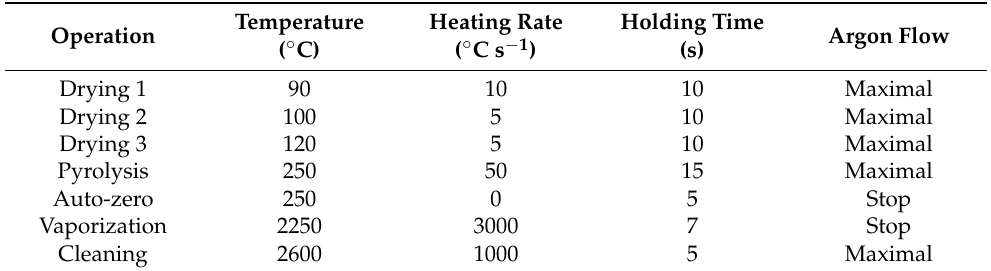
Table 3. Elaborated time-temperature program used for the determination of GSH based on measur- ing sulfur in terms of CS ( λ = 258.0560